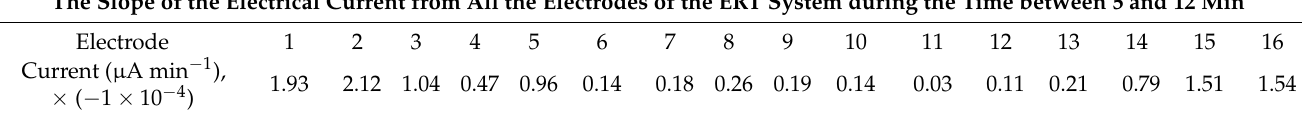
Table 4. Assessment of the slope of the electrical current between 5 and 12 min from all the electrodes of the ERT system. The data describe the malfunction scenarios for case no. 1 in Table 3 and Figure 9. The Slope of the Electrical Current from All the Electrodes of the ERT System during the Time between 5 and 12 Min